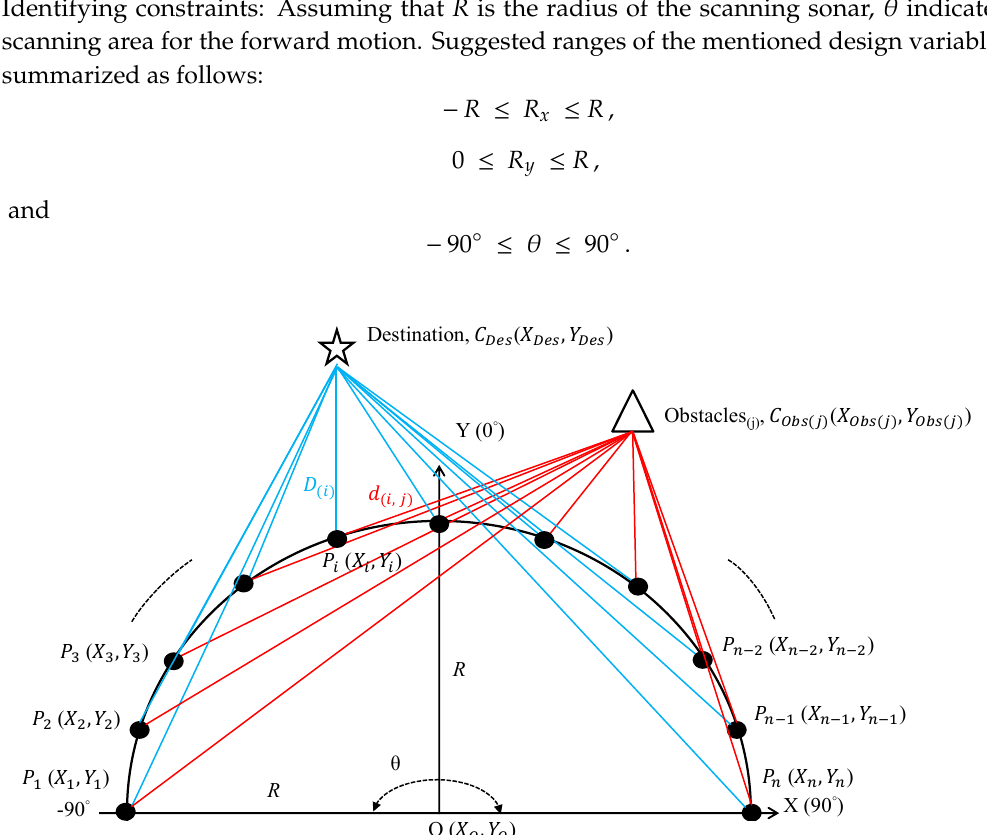
Figure 6. Optimum value computing of the obstacle avoidance approach: the destination C Des , the obstacles C Obs , the point P on the radius of the scanning sonar, the distance D i between point P and the destination, and the distance d ( i , j ) between point P and the